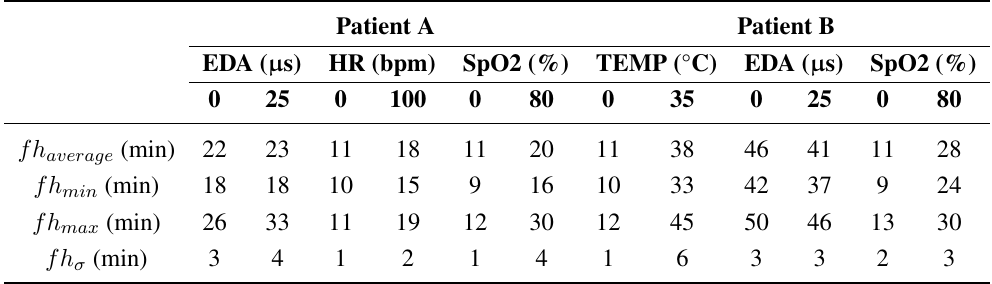
Table 4. Robustness analysis. Horizons of prediction for fit at